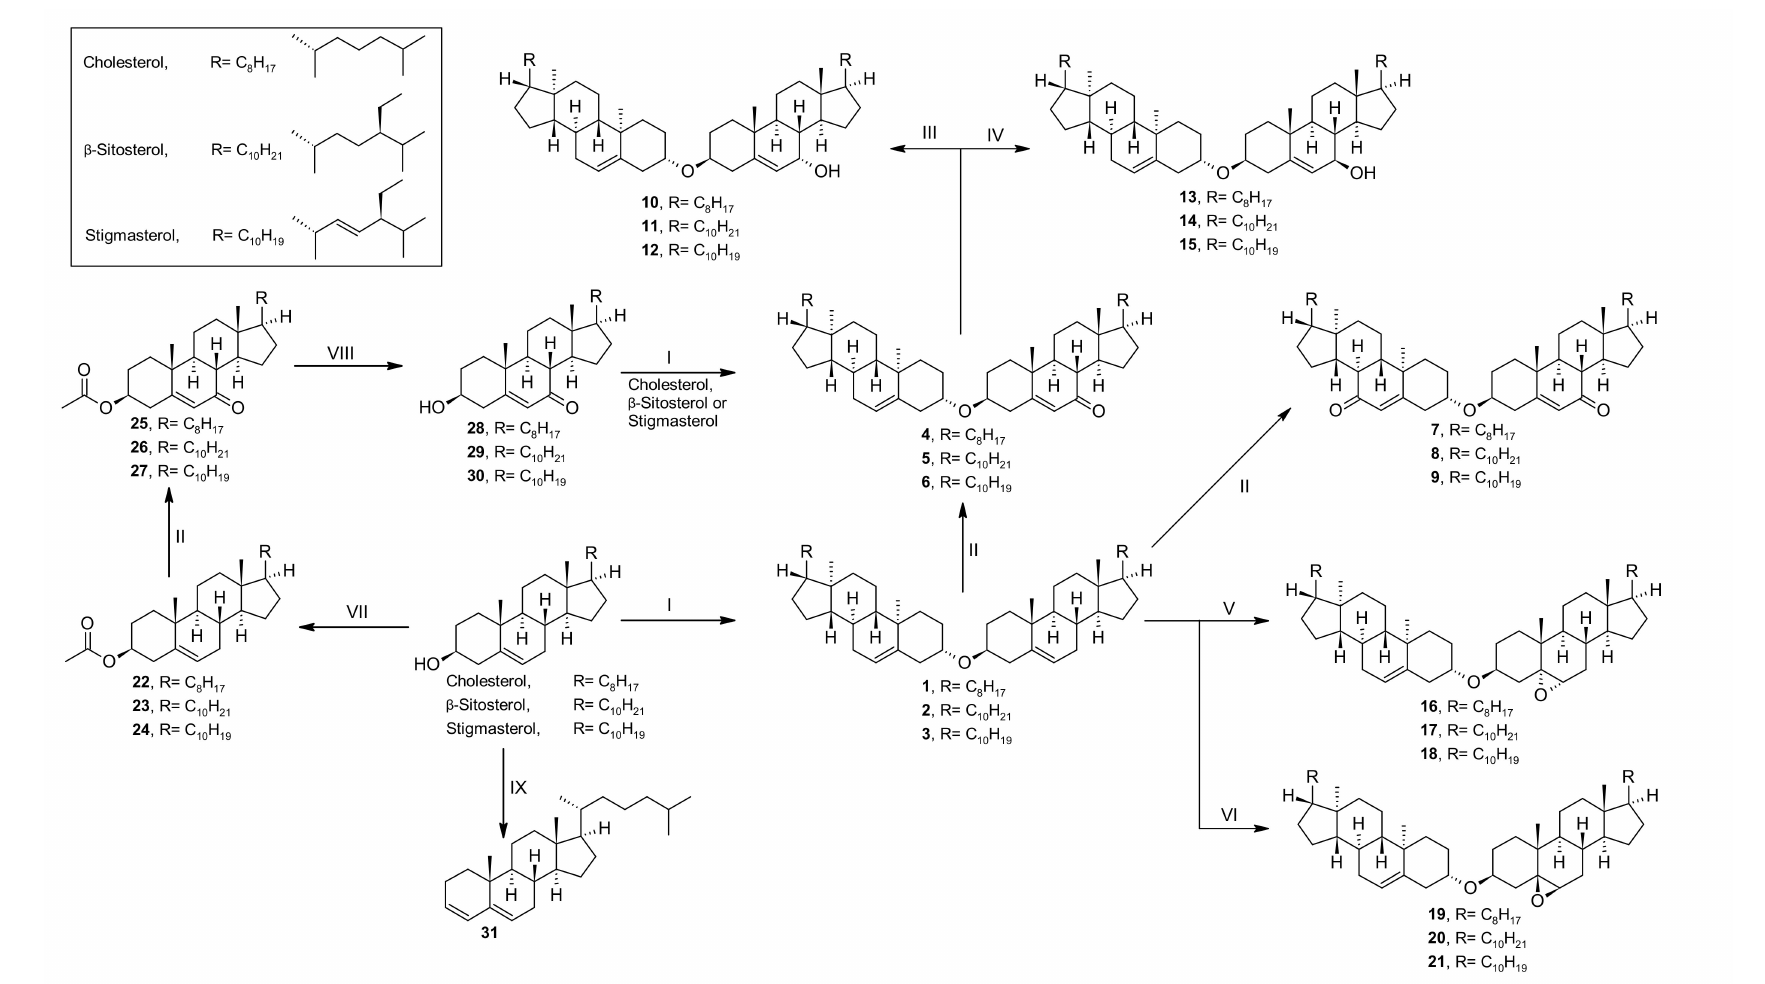
Figure 1. Synthesis of sterol